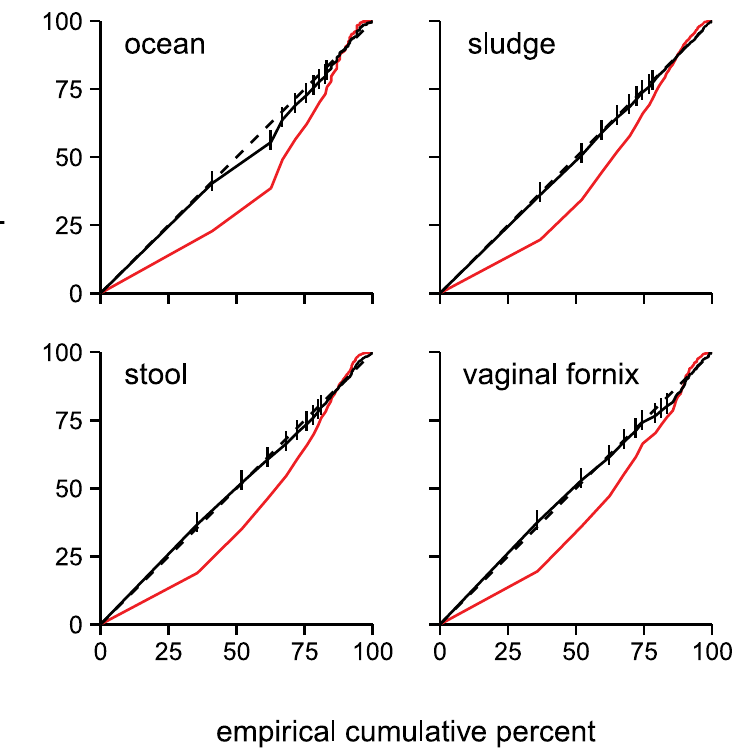
Fig 2. TPL distribution fits OTU abundance distributions in multiple ecosystems. Probability-probability plots comparing the empirical cumulative distribution function (horizontal axis) with the theoretical cumulative probability of a TPL distribution fit to each data set (vertical axis, black solid line). The first ten data points are marked with vertical dashes: the first dash (furthest lower left) represents the fraction of OTUs that have 1 read, the second dash represents the fraction of OTUs with 2 or fewer reads, and so forth. The dotted black line indicates a perfect fit of the TPL to the empirical distribution ( y = x ). The theoretical cumulative probability of a simple lognormal distribution (red line) is shown to emphasize the quality of the TPL fit. The ecosystems are ocean water from this study (top left), wastewater sludge from this study (top right), human stool (bottom left; Human Microbiome Project [HMP] sample), and human vagina (bottom right; HMP sample). 99% de novo OTUs are shown for all